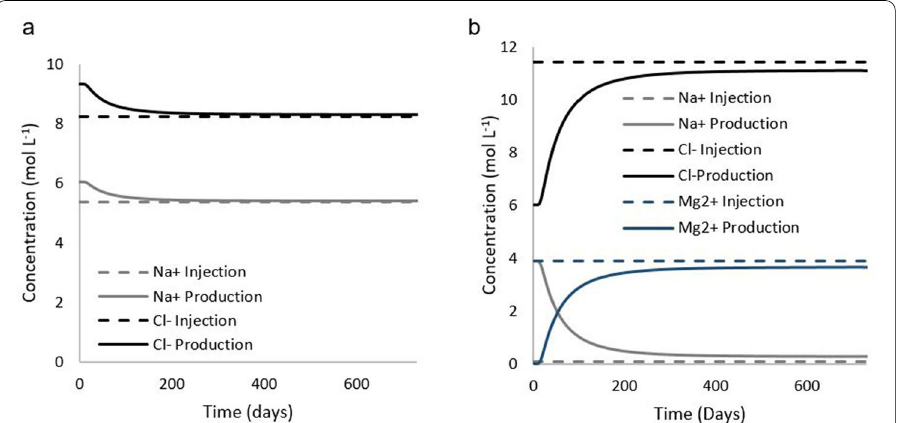
Fig. 6 Comparison of Cl − , Mg 2 + , and Na + concentration at the production well over 730 days (2 years) in a geothermal doublet system initially saturated with NaCl, injected with a NaCl-brine and b MgCl 2 -brine heat exchange